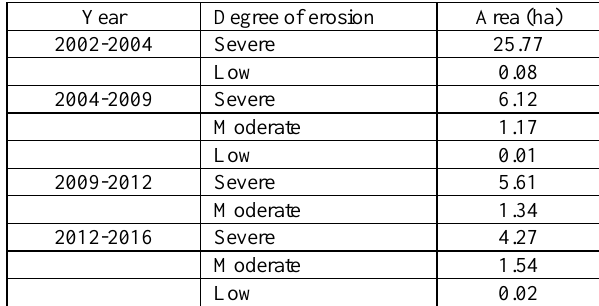
Table 3. Coastal erosion between 2002 and